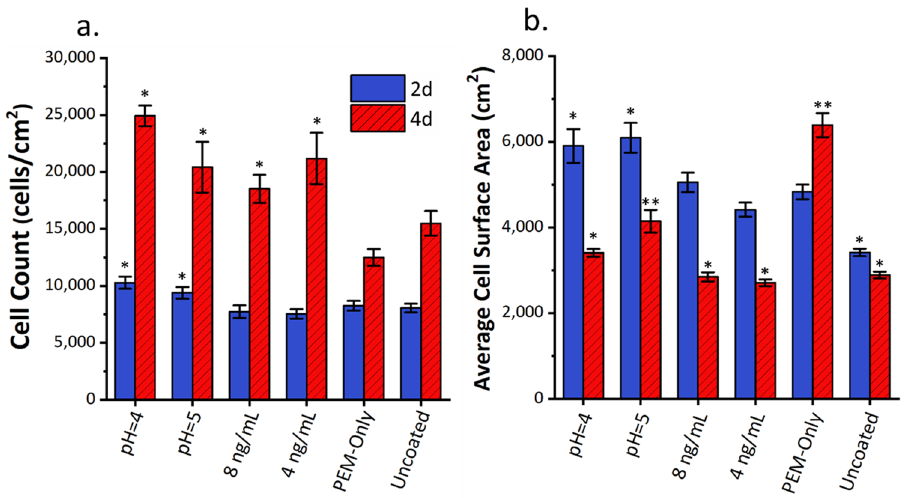
Figure 6. Comparison between 2-day and 4-day results for ( a ) cell counts obtained from Hoechst 33342 nuclear staining and ( b ) average cell surface areas from phalloidin labeling. Error bars represent standard error (n = 12). *Represents statistical differences from PEM-only control of the same time point (p < 0.05). **Represent statistical differences from all other conditions at the same time point (p <